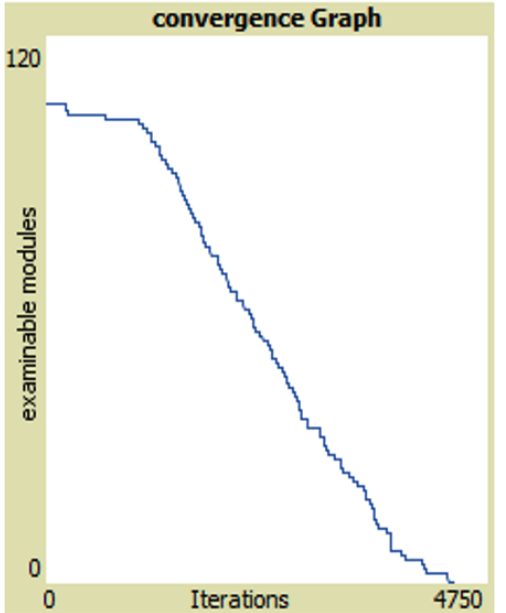
Figure 8: The Number of Iteration (10 Agents). Figure 9: Experiment Using 100 Agents